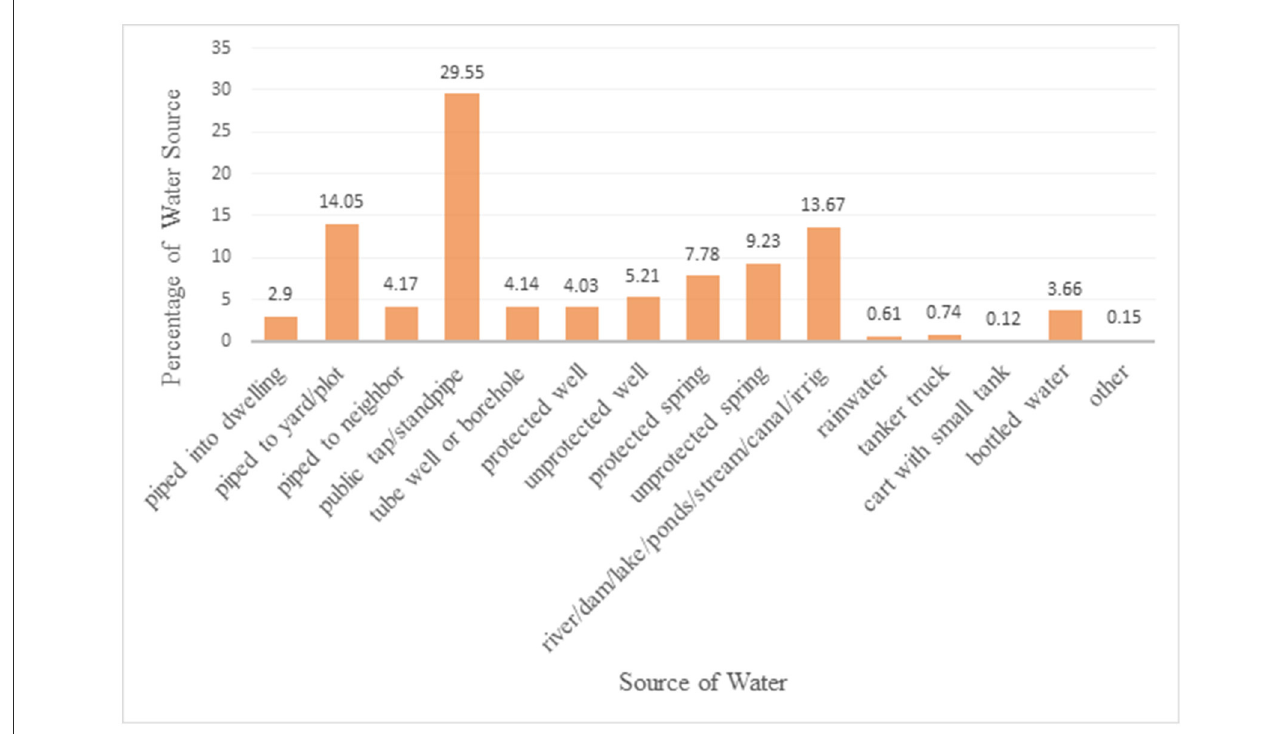
FIGURE1 Proportion of different water sources based on the EMDHS 2019 datasets.